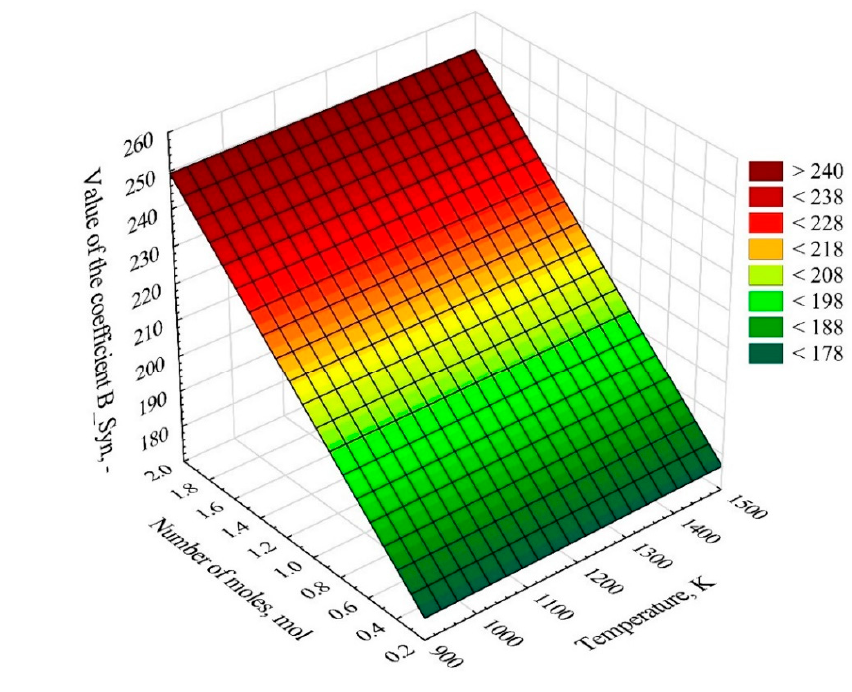
Figure 8. Value of the syngas compression ratio as a function of the number of moles of the gasification agent (x) and the temperature (y) of the gasification process using CO 2 .